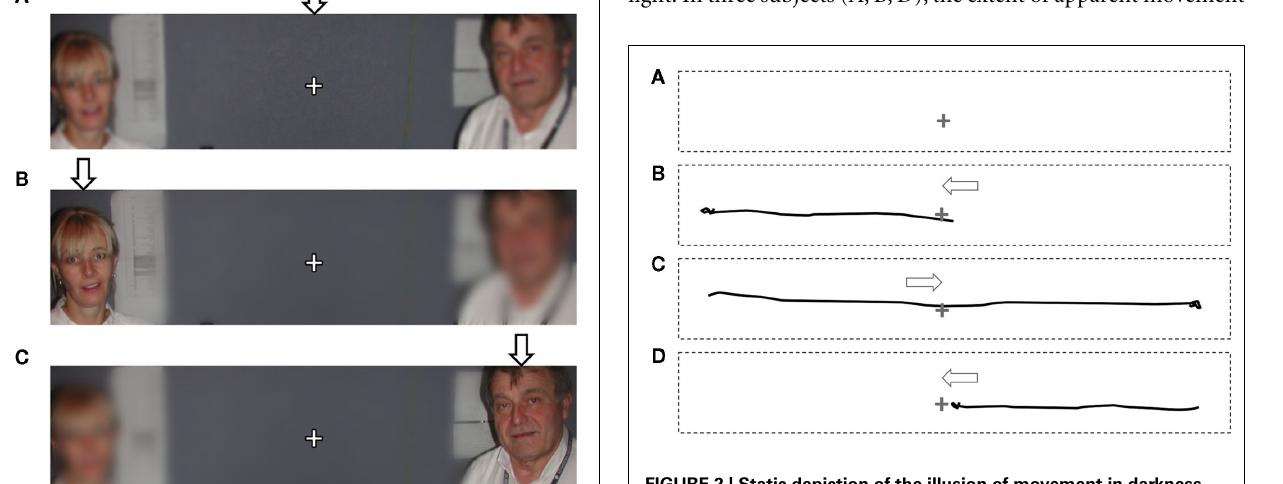
FIGURE 2 | Static depiction of the illusion of movement in darkness during paralysis. Subjects were presented with a point of light (indicate by + ) in the center of the foveal field surrounded by darkness.When attempting to gaze away from the light (without actual movement of the foveal field due to paralysis), subjects report movement of the light with a trajectory consistent with the direction of attempted gaze.The perceptions were, consecutively: rest (A) , attempted gaze to left (B) , attempted gaze to right (C) , and return (D) .The solid black lines depict the trajectory of the illusory movement of the point of light.The arrows indicated the direction of the attempted gaze.The supplementary material shows an animation of this